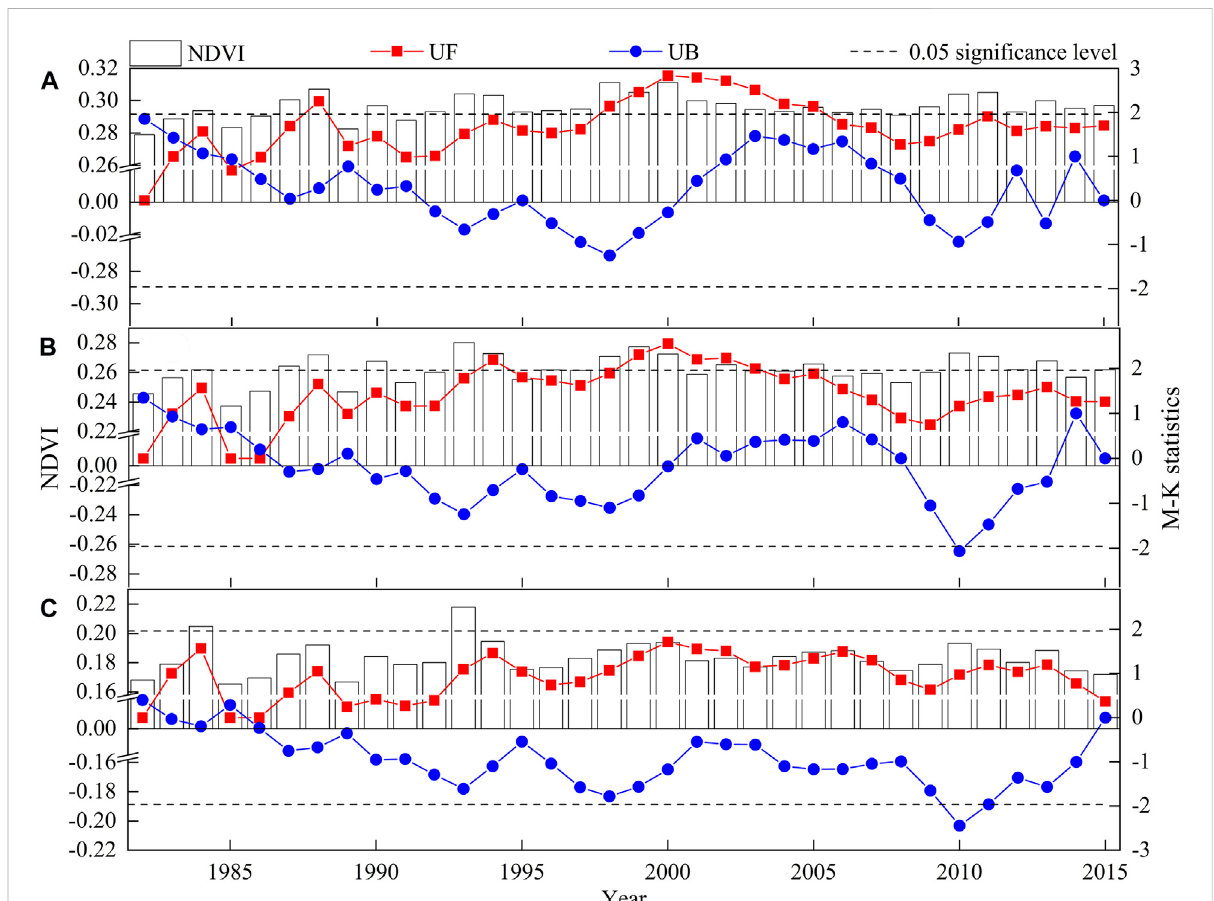
FIGURE 2 Interannual variation trend and the Mann – Kendall test of the NDVI of meadow (A) , steppe (B) , and desert grassland (C) in Xinjiang. (Note: if the UFvalueisgreaterthan0,itindicatesthattheNDVIsequencehasanupwardtrend;otherwise,ithasadownwardtrend.WhenUFexceedsthecritical line, it indicates that the trend of the sequential NDVI has a signi fi cant increase or decrease. When UF and UB intersect at the critical boundary, the point at which the two curves intersect is the point where the mutation begins. The critical line is the 0.05 signi fi cant